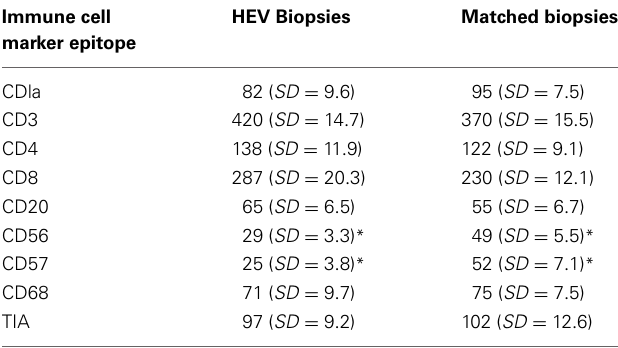
Table 4 | The number of liver infiltrating inflammatory cell s #